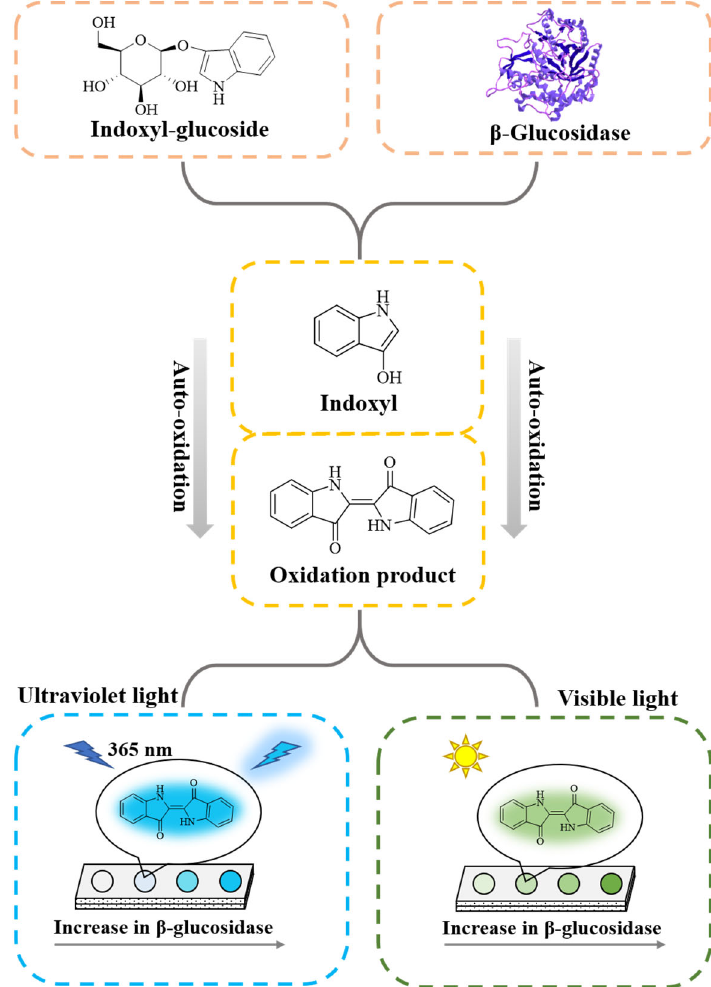
Figure 1. Schematic illustration of fluorescent and colorimetric dual ‐ mode detection of β -glucosidase, based on the paper ‐ based device using indoxyl ‐ glucoside as a substrate.